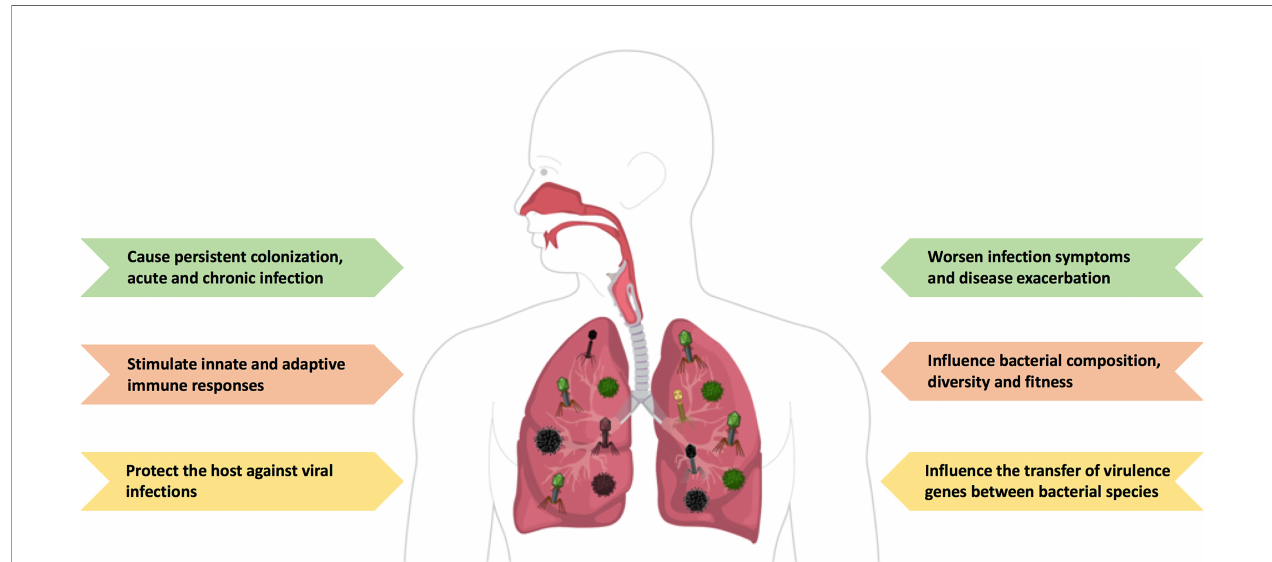
FIGURE 1 | The ambiguous role of the lung virome during pulmonary viral infections. The human lung is populated by different viruses and their genomes (called ‘ the virome ’ ), including DNA and RNA viruses, and bacteriophages. The lung virome has been shown to have a protective role by stimulating a continuous antiviral response. However, higher viral loads may have harmful consequences to the host and exacerbate disease pathogenesis, either infectious or non-infectious. Figure created with